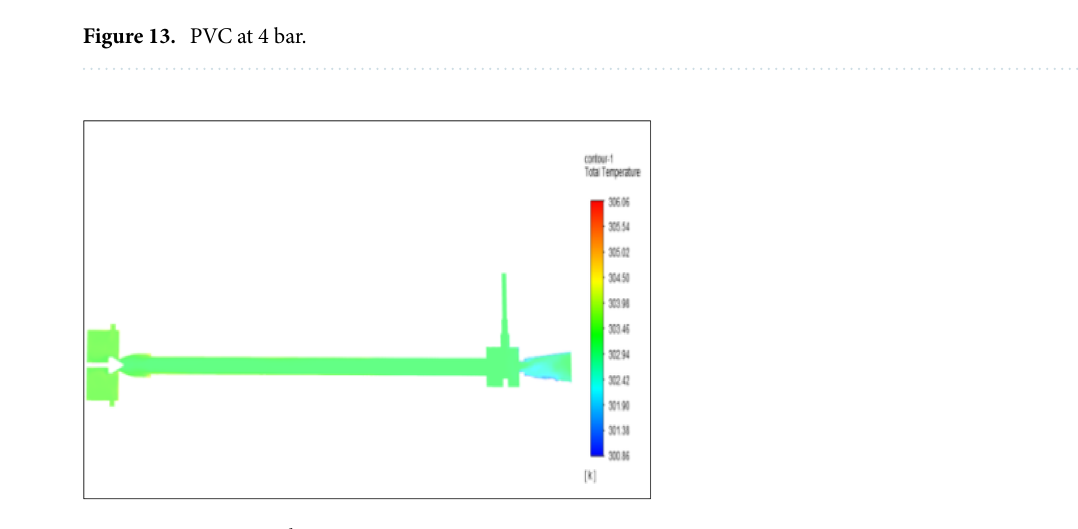
Figure 14. CPVC at 4